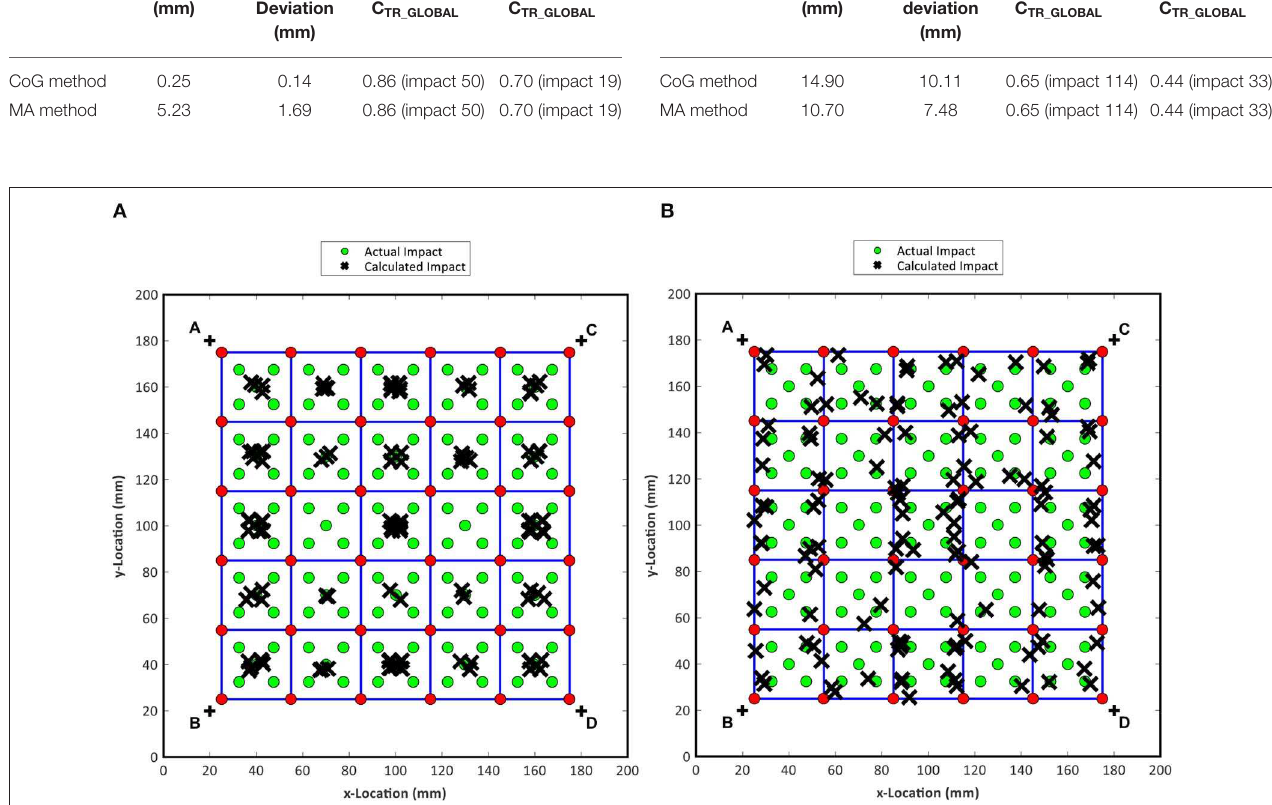
FIGURE 6 | Calculated and actual impact locations for the CoG method (A) and the new topological MA approach (B) applied to TR with off-centered impacts and grid refinement.